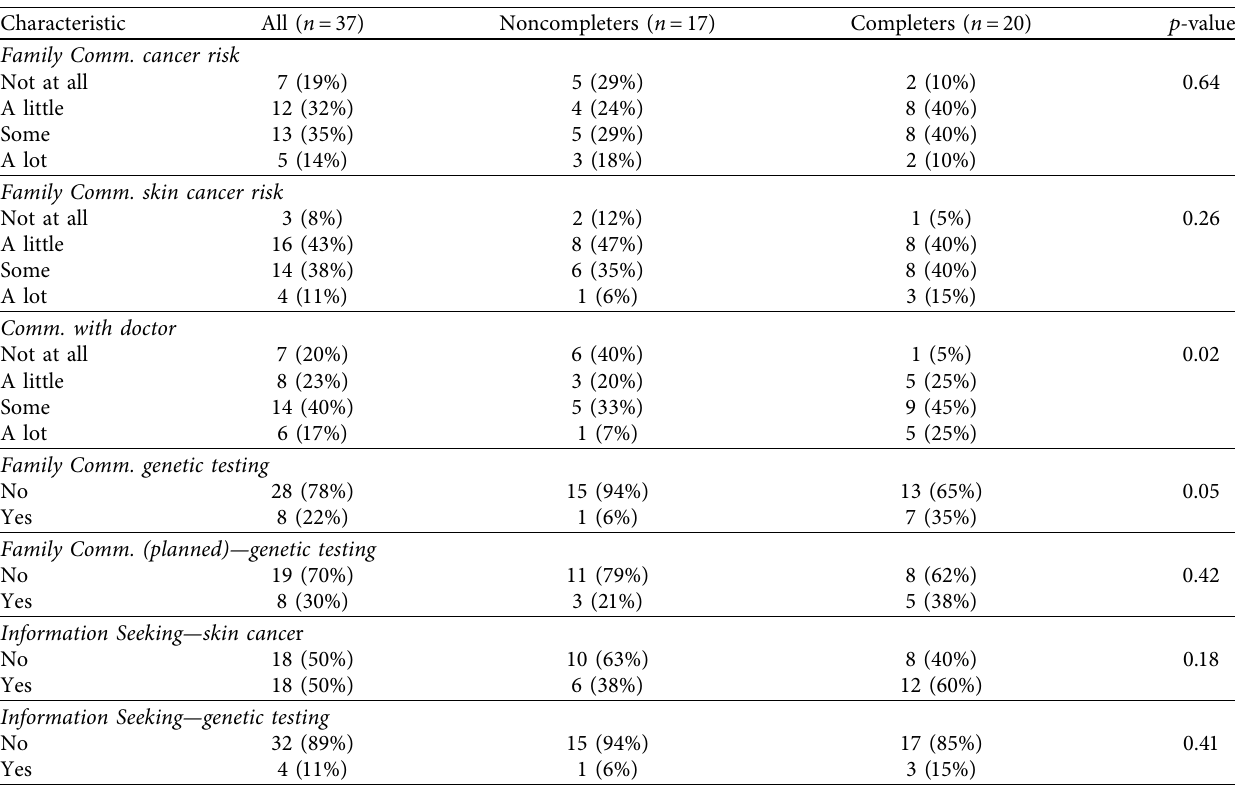
Table 3: Communication and information seeking outcomes at three months, by saliva sample return status. Characteristic